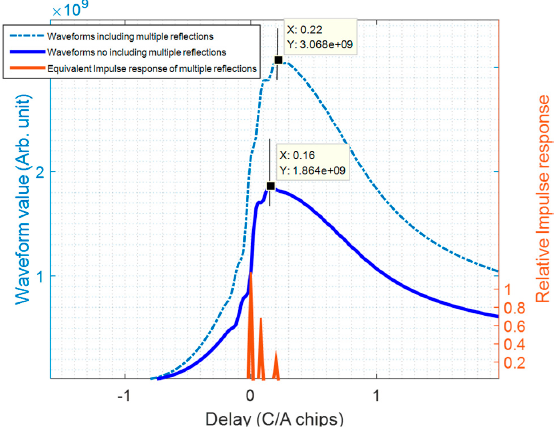
Figure 12. Example of the impact of multipath in the ISS structure.